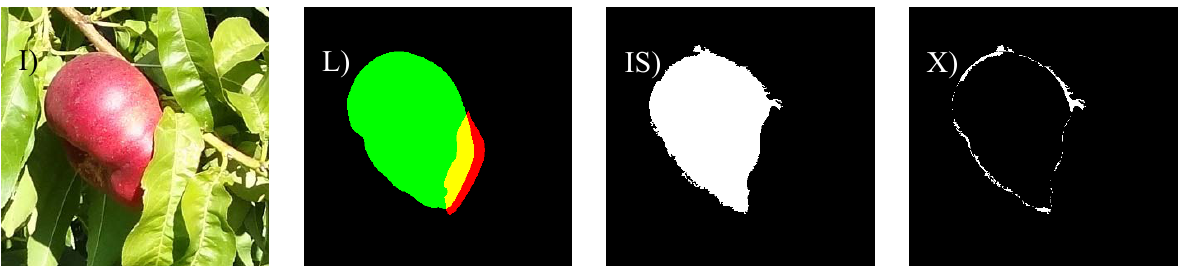
Figure 13. Sample image with an occlusion of 34.5%.